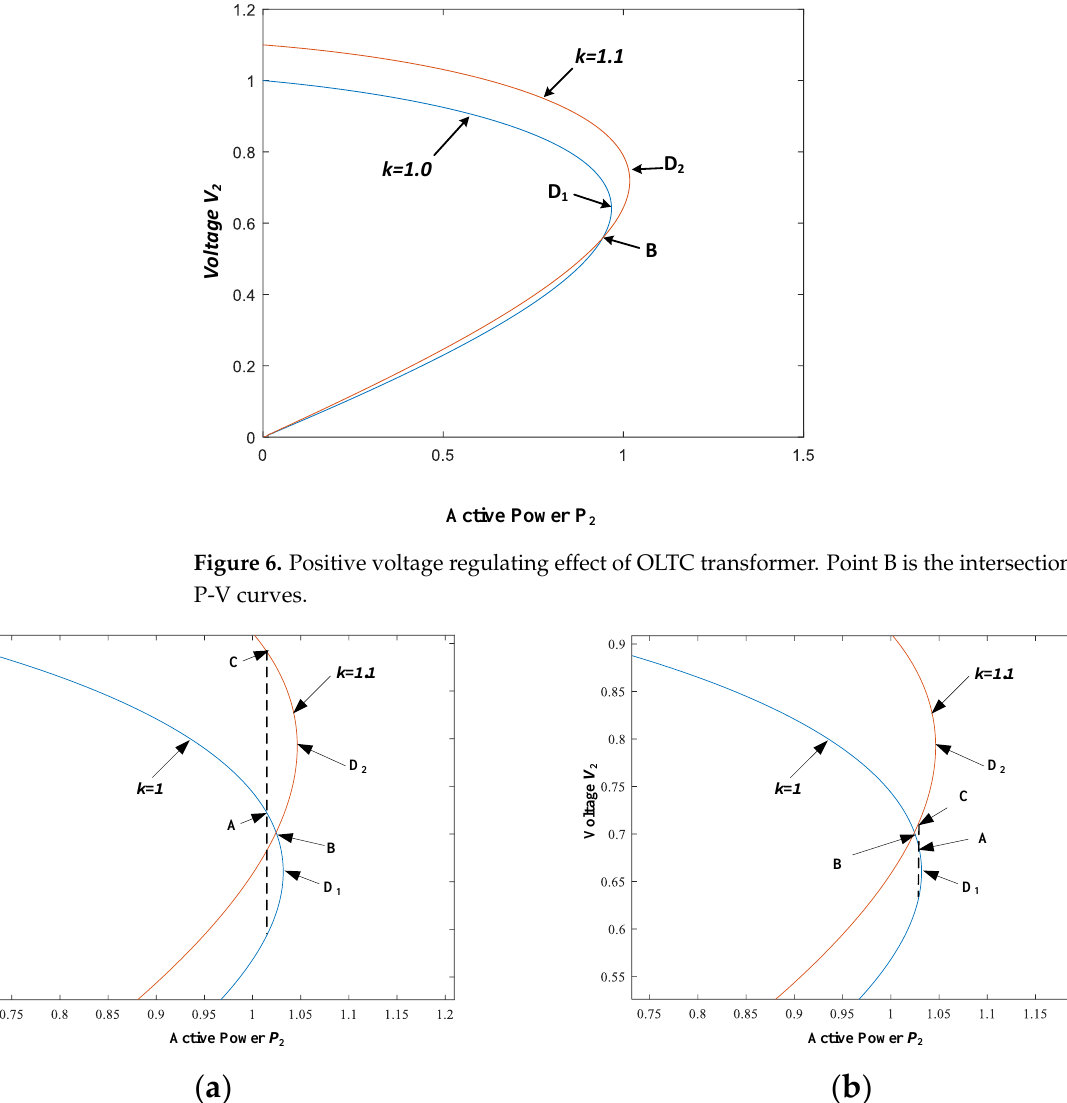
Figure 7. Deviation effect of critical operating point of OLTC transformer. ( a ) Positive adjustment; ( b ) Negative adjustment. Point A is initial operating point. Point B is the intersection of two P-V curves. Point C is operating point after OLTC action.